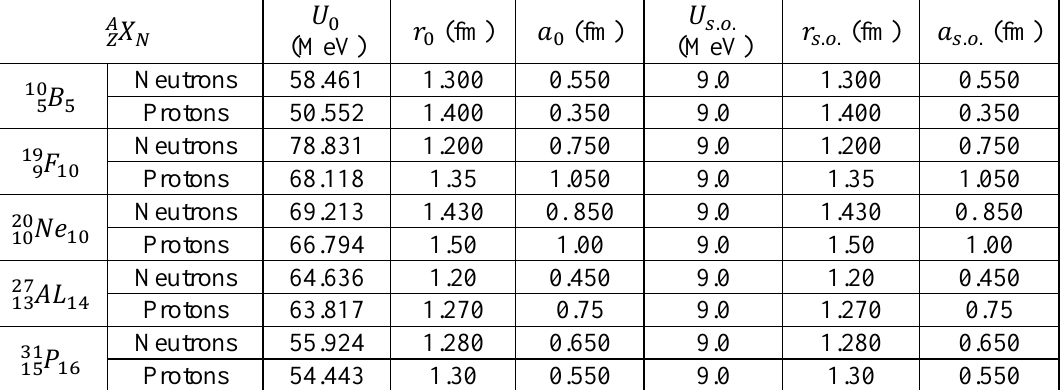
Table 1: Parameters of Woods-Saxon potential for stable , , , and nuclei.